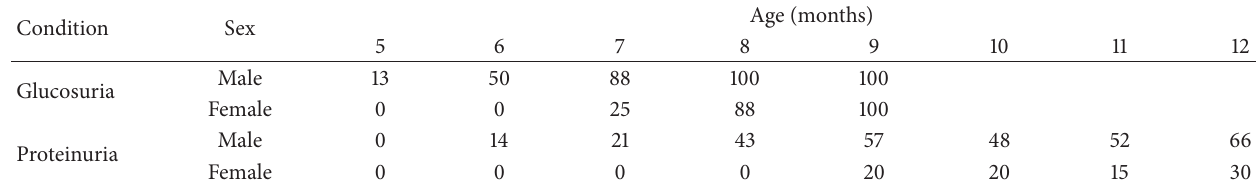
Table 1: Incidence of glucosuria and proteinuria in LEA rats (%).